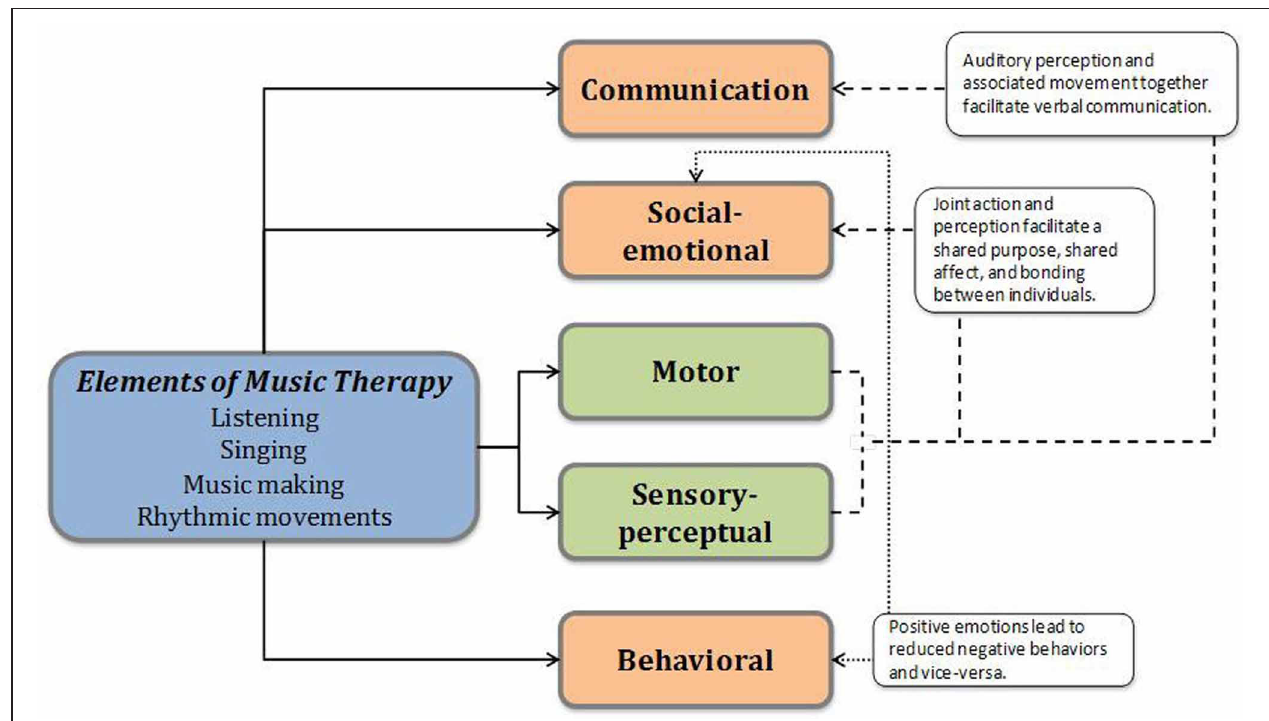
FIGURE 1 | Direct and indirect influences of musical experiences/therapies on the various domains of development.